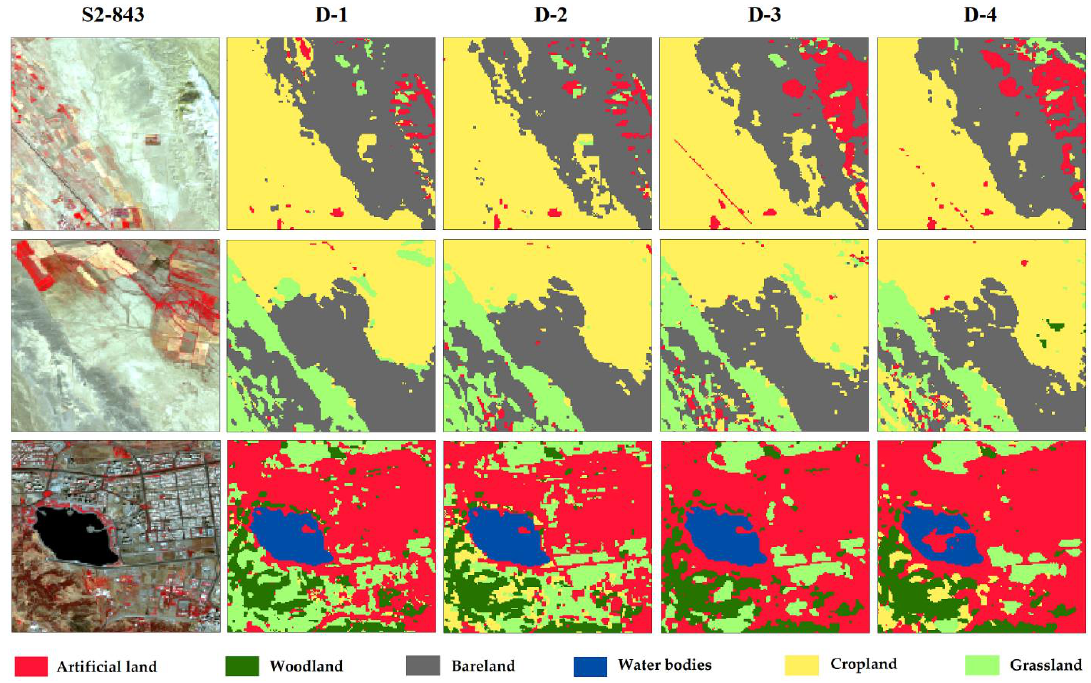
Figure 5. Comparison between the classification results of different parts of the study area. (D-1) S- 2 seasonal composites, (D-2) S-2 percentile metrics, (D-3) L-8 seasonal composites, and (D-4) L-8 percentile metrics.